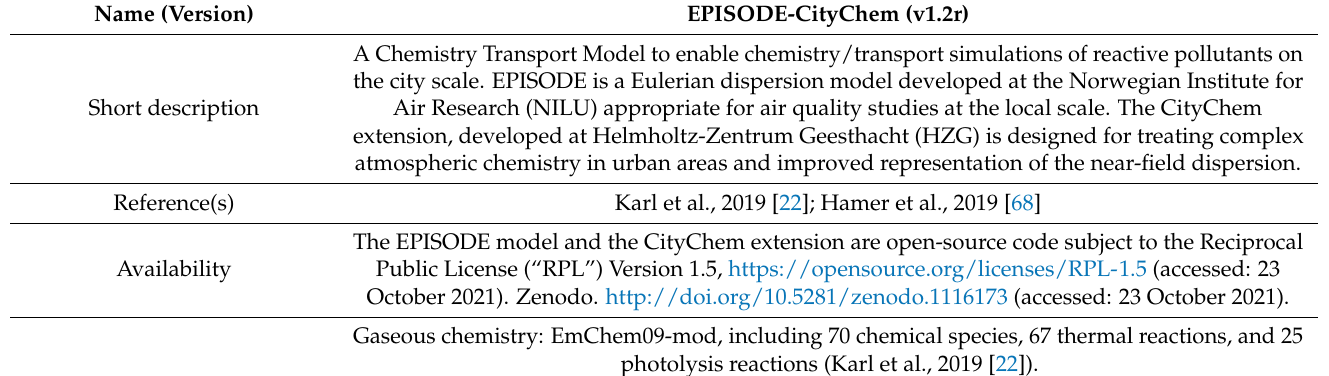
Table A1. Model description and setup for the case studies of Athens and